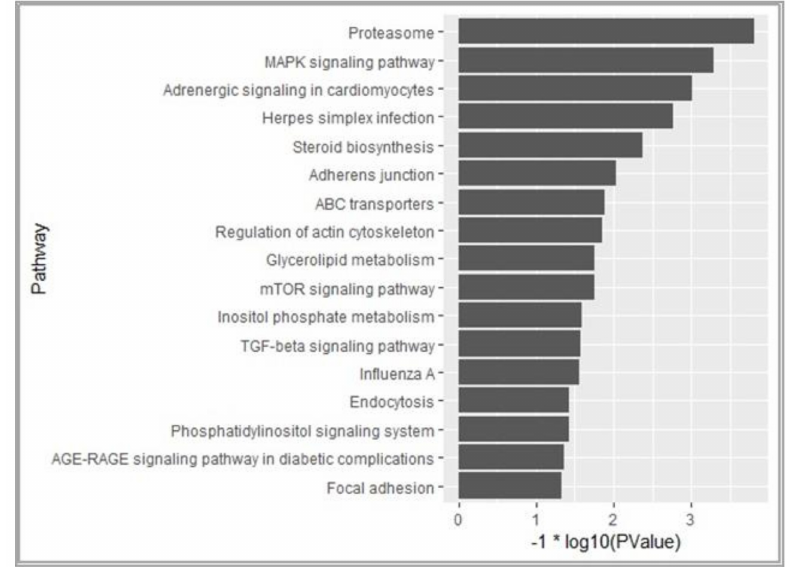
Figure 5. Enriched pathways based on the 1461 DEGs. KEGG (Kyoto Encyclopedia of Genes and Genomes) pathway analysis of DEGs showed that various fat metabolism pathways (glycerolipid metabolism, steroid biosynthesis etc.) were enriched ( p <